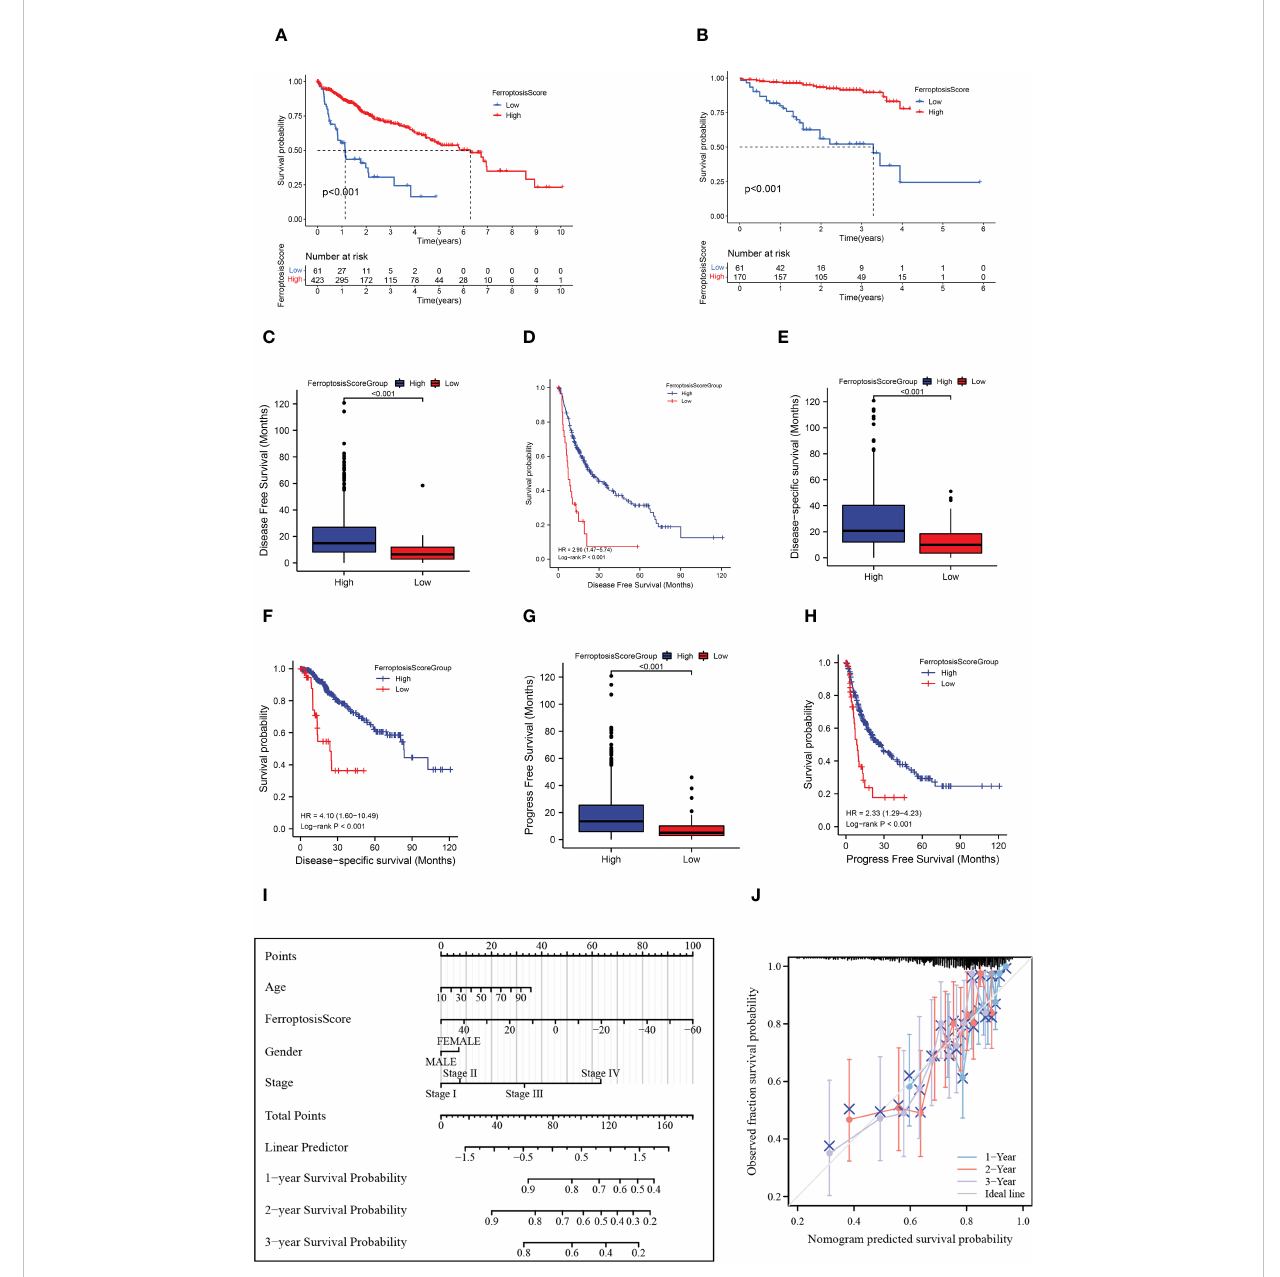
FIGURE 6 HCC prognosis based on the ferroptosis score. (A, B) Kaplan-Meier survival curves for the ferroptosis score groups in TCGA+GEO (A) and ICGC (B) . (C) Box plots showed the differences in disease-free survival (DFS) between ferroptosis score groups. (D) Kaplan-Meier curves for the ferroptosis score groups in disease-free survival (DFS). (E) Box plots showed the differences in disease special survival (DSS) between ferroptosis score groups. (F) Kaplan-Meier curves for the ferroptosis score groups in disease special survival (DSS). (G) Box plots showed the differences in progression-free survival (PFS) between ferroptosis score groups. (H) Kaplan-Meier curves for the ferroptosis score groups in progression-free survival (PFS). (I) Nomogram plot of prognostic multivariate regression model. (J) Prognostic Calibration plot evaluating the fi t analysis of the model to the actual